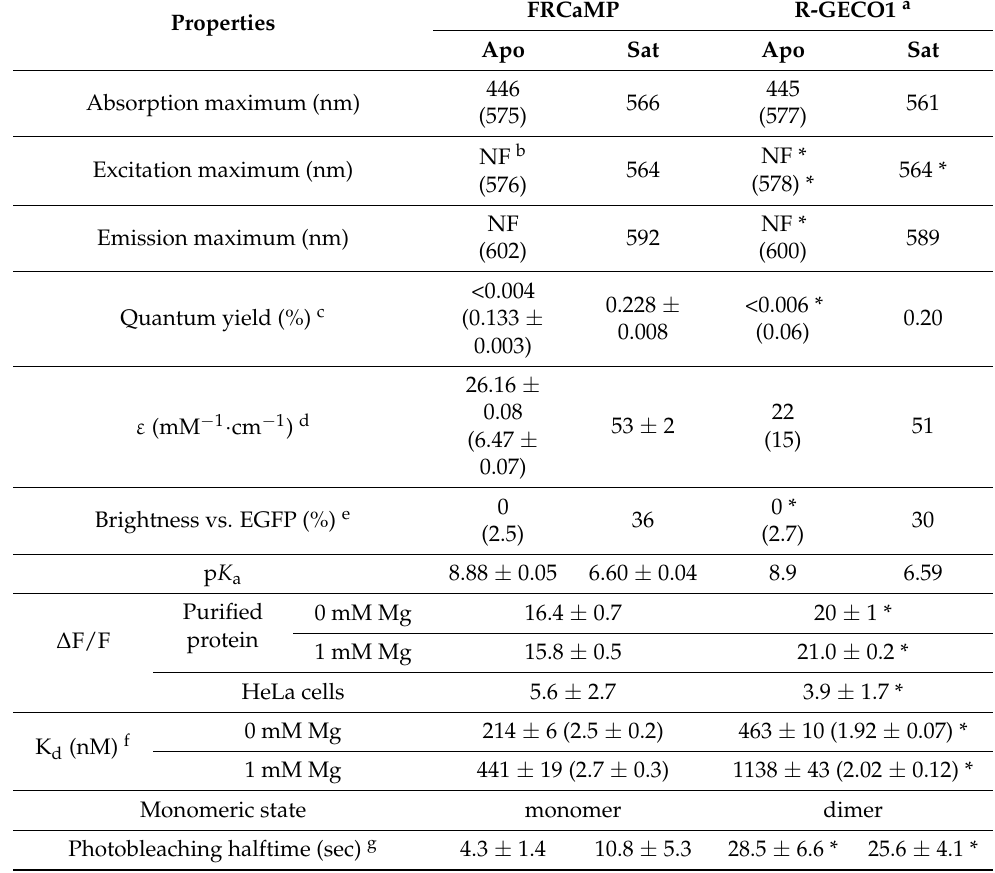
Table 1. In vitro properties of the FRCaMP calcium indicator compared to the R-GECO1